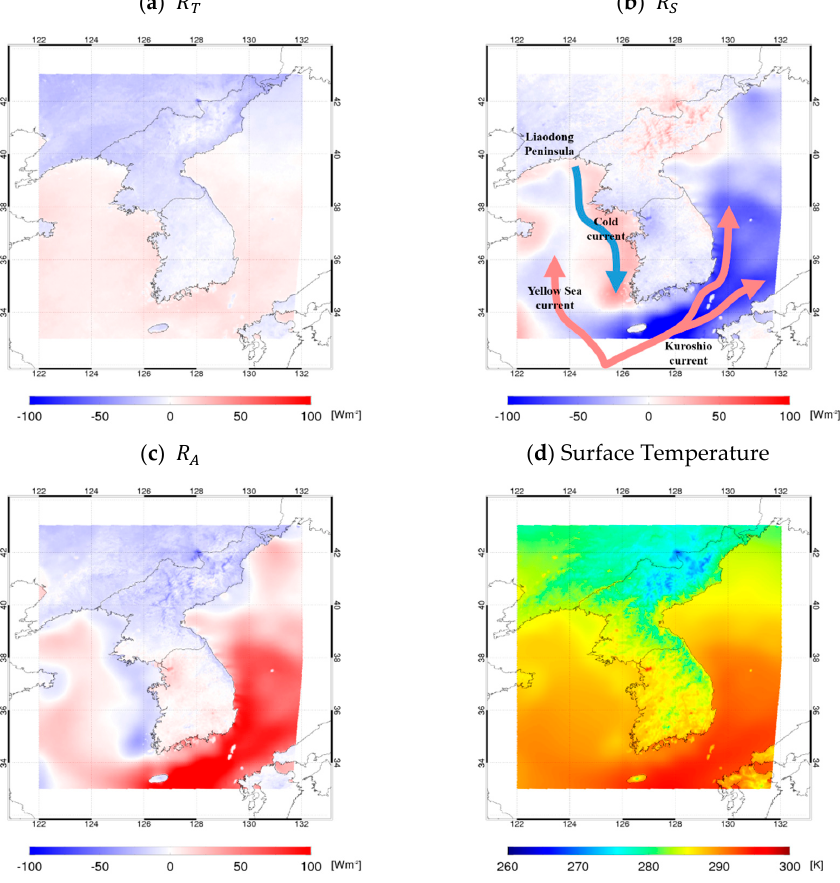
Figure 11. Annual mean energy budget for 2016 at ( a ) the top of the atmosphere; ( b ) the surface; and ( c ) in the atmosphere; and ( d ) surface temperature distribution.